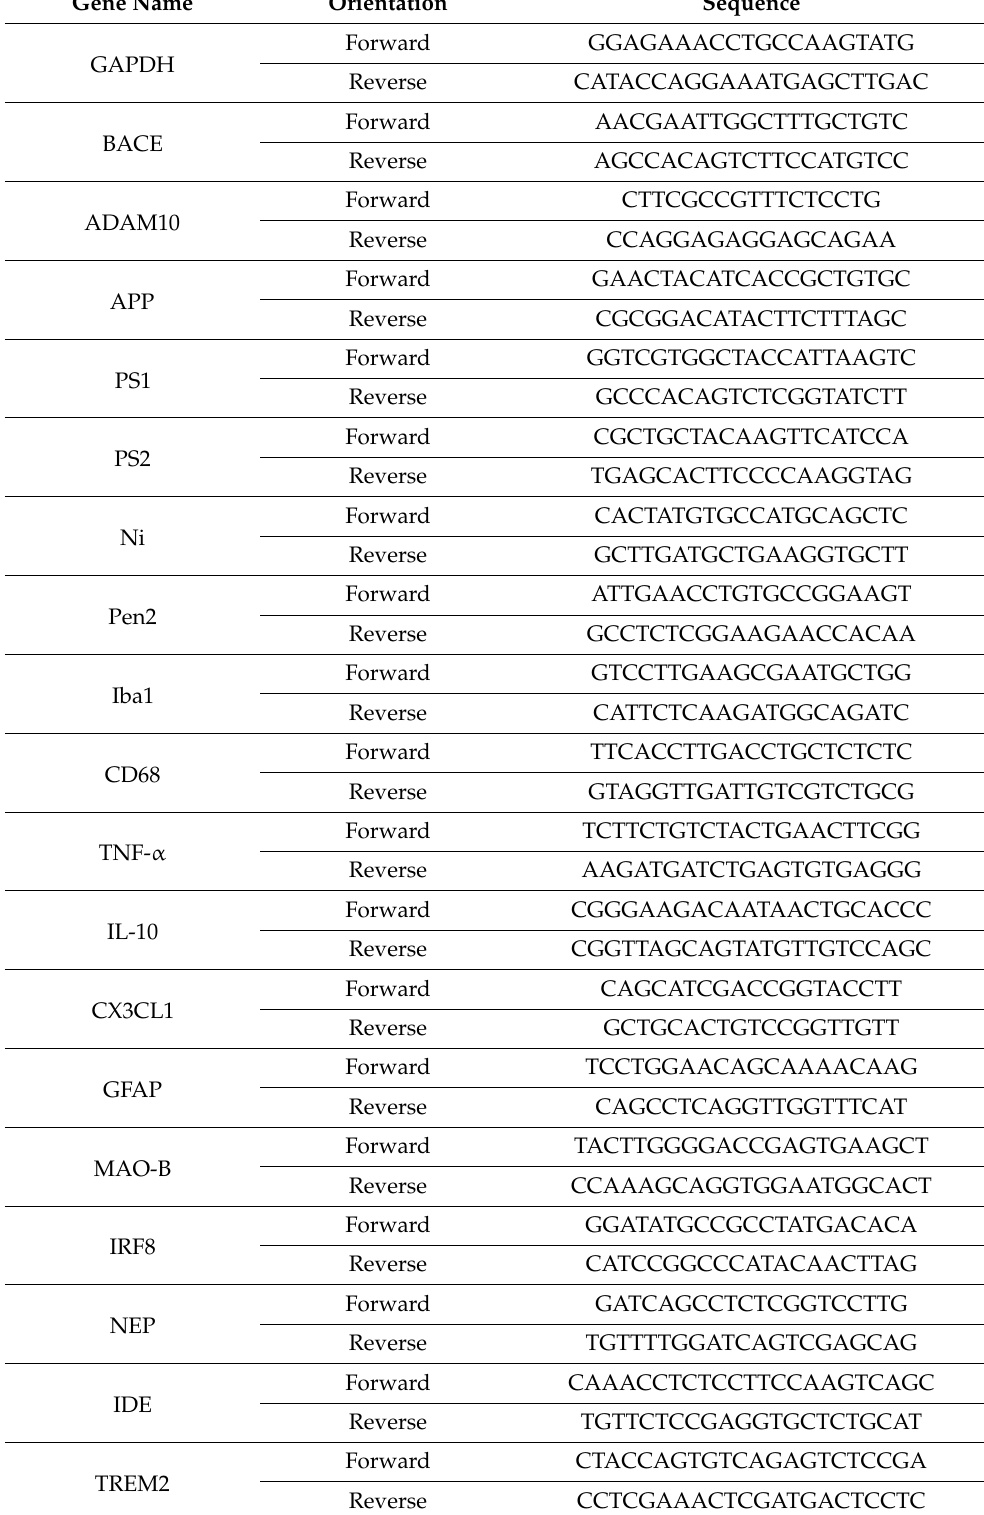
Table 1. List of primers used for